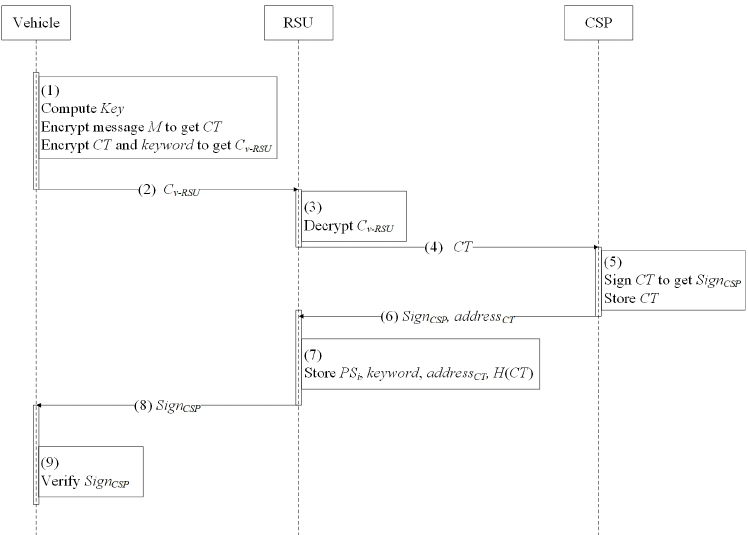
Figure 4. Data uploadng